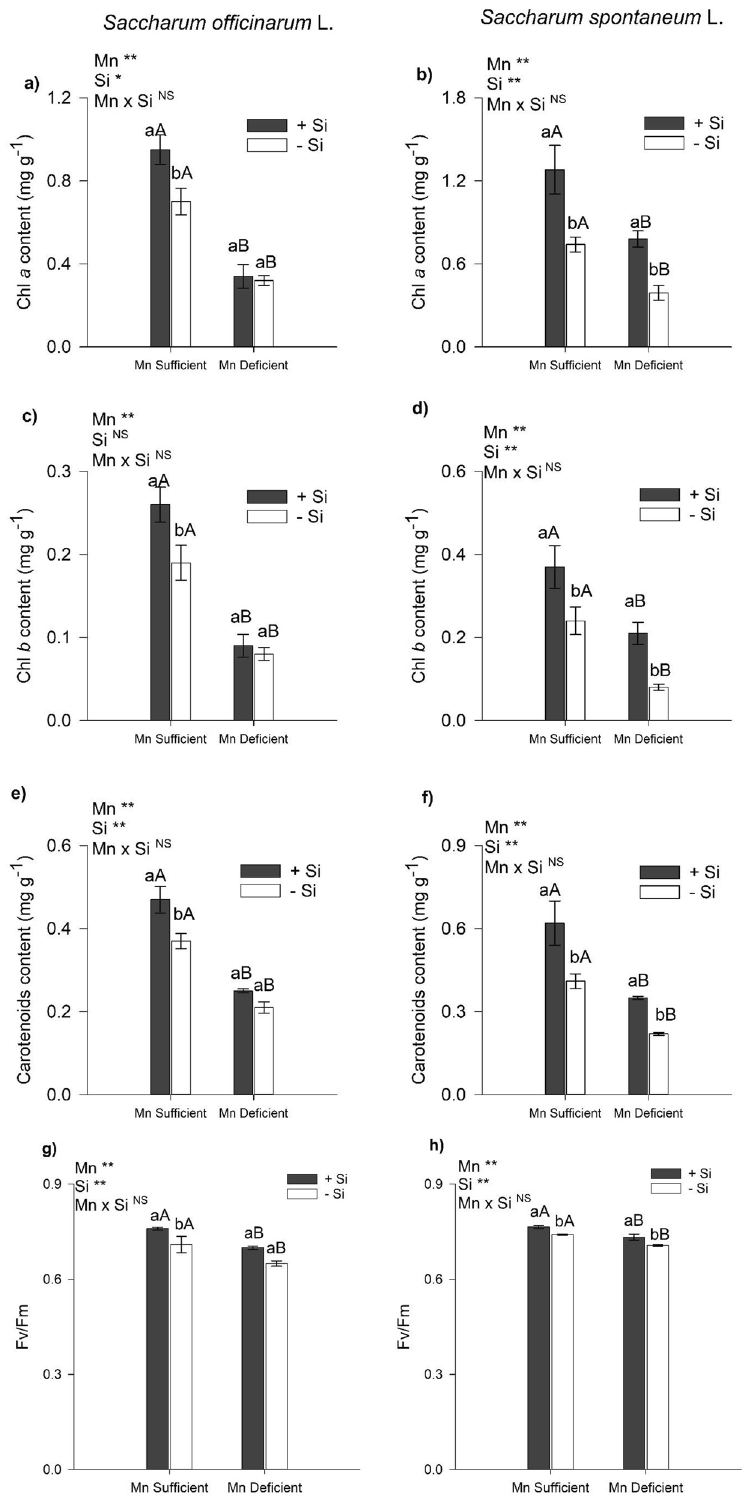
Figure 3. Content of chlorophyll a ( a , b ), chlorophyll b ( c , d ), carotenoids ( e , f ), and photosystem II quantum efficiency ( g , h ) of sugarcane ( Saccharum officinarum L.) and energy cane ( Saccharum spontaneum L.) plants, respectively, grown in Mn-sufficient and deficient nutrient solution in the absence (− Si) and presence (+ Si) of Si. F-test was applied: *( p ≤ 0.05); **( p ≤ 0.01), and ns not significant. Different lowercase letters compare Si conditions under the same Mn condition ( p < 0.05 the Tukey test), while different uppercase letters compare Mn conditions under the same Si condition ( p < 0.05 by Tukey test). Bars represent the mean standard error, n =